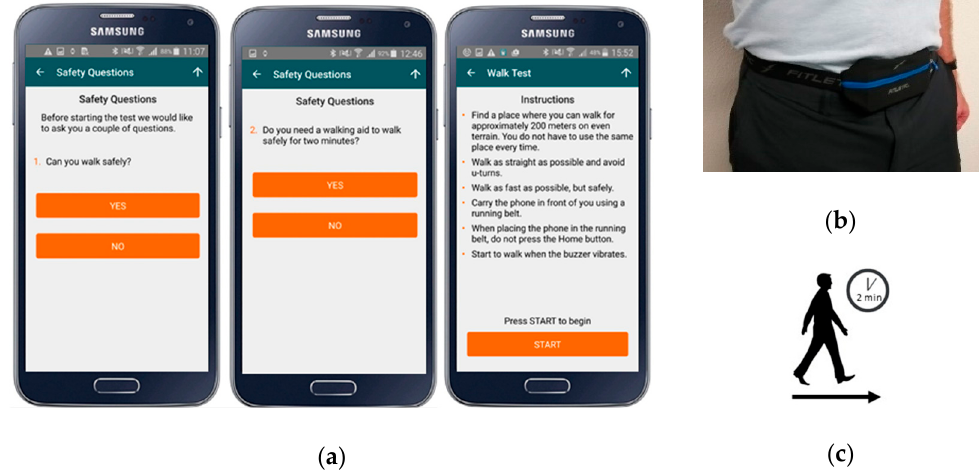
Figure 2. ( a ) The instructional screens provided to the participant, ( b ) a smartphone attached at the waist using a belt-bag and ( c ) summary description of the 2-minute walk test (2MWT). Participants were provided with a Samsung Galaxy S7 smartphone by the study investigator.